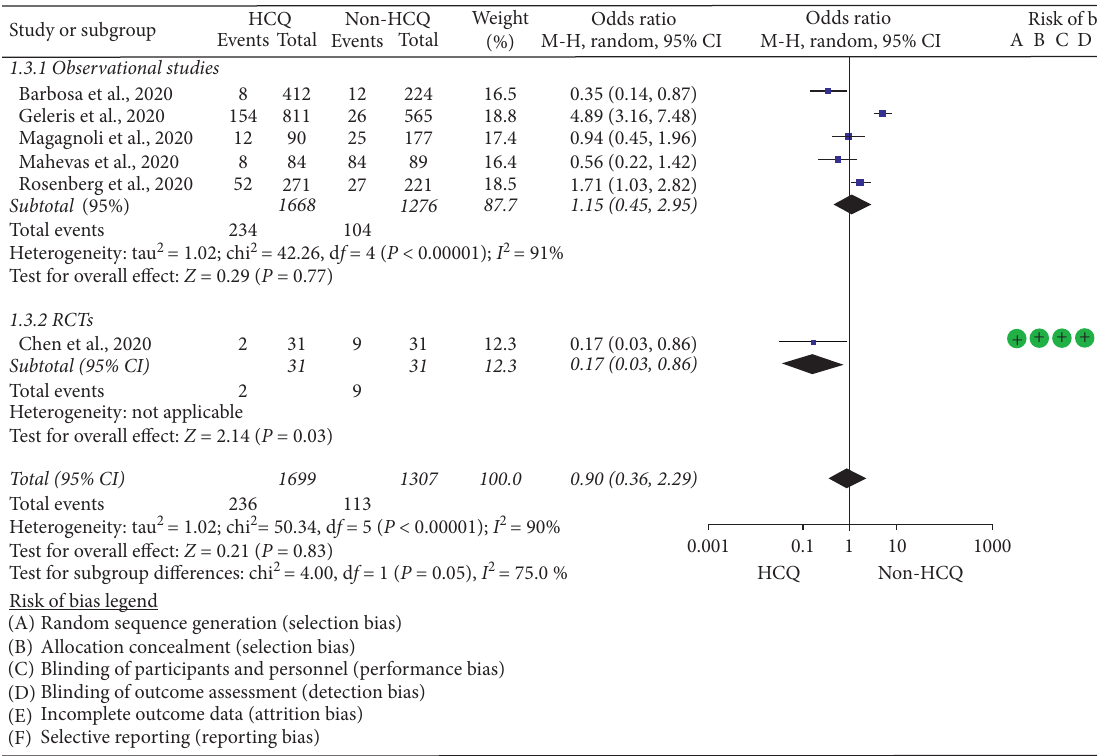
Figure 5: Risk of disease progression among COVID-19 patients exposed to HCQ versus non-HCQ.